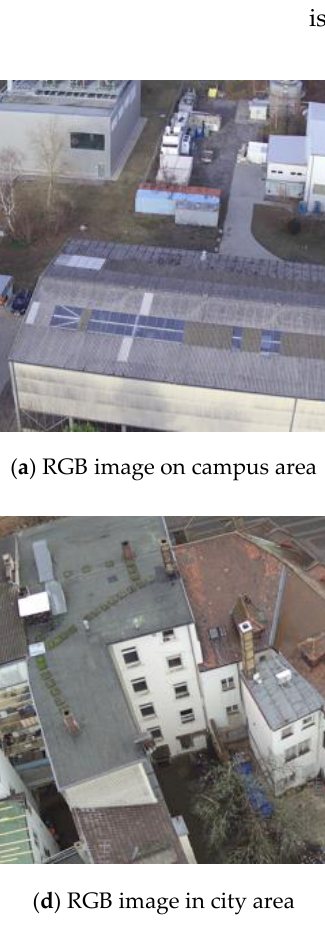
Figure 3. Examples that explain thermal image rendering.